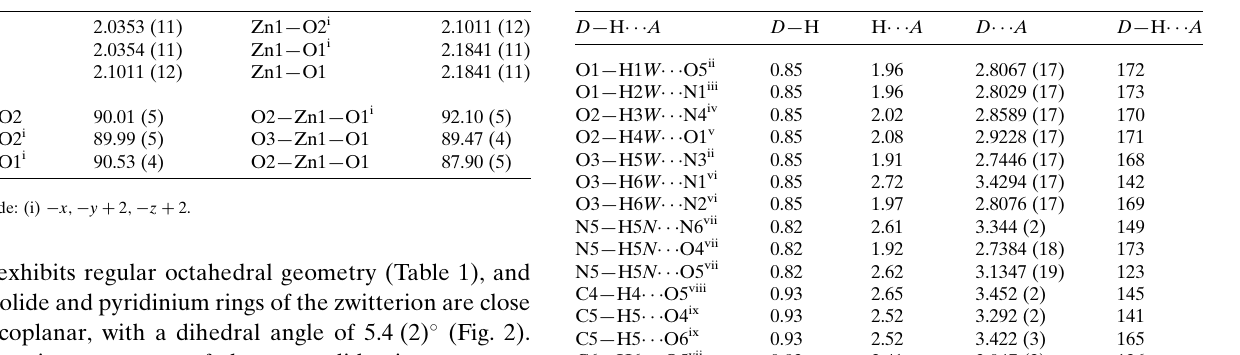
Table 1 Selected geometric parameters (A˚ , (cid:4) ).